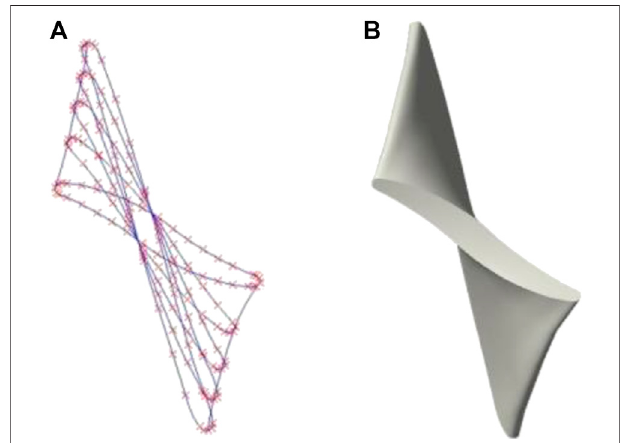
FIGURE 6 | Three-dimensional solid modeling of blades. (A) Three- dimensional spatial data points. (B) Model.